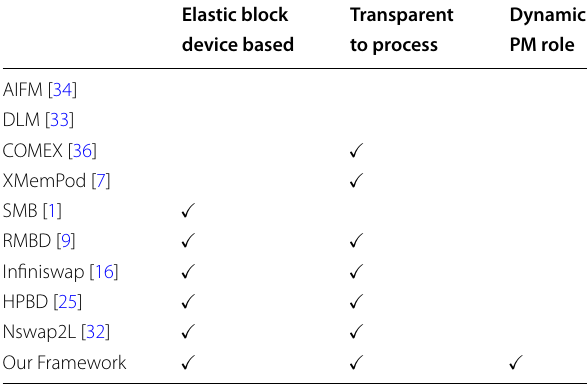
Table 2 Comparisons of our method in this paper with existing solutions